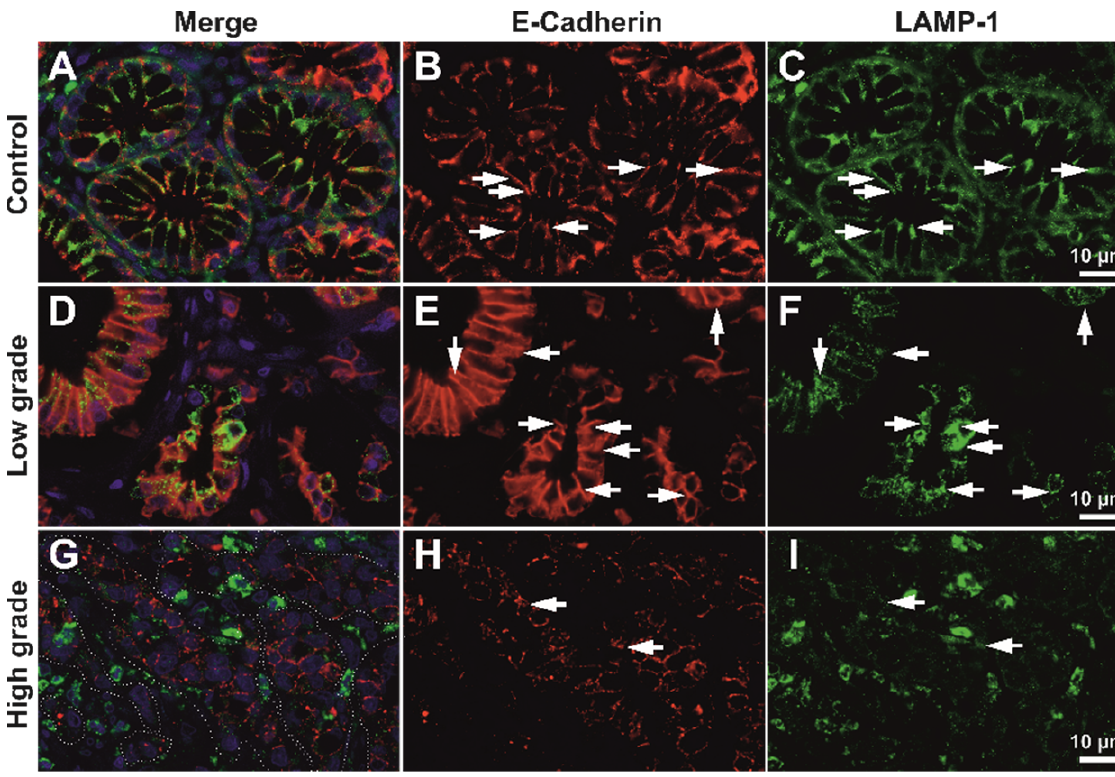
Figure 6. Exemplary deconvolved working images of double immunofluorescence for E-cadherin and LAMP1. Epithelia of control tissue ( A – C ), low-grade ( D – F ) and high-grade ( G – I ) adenocarcinoma were analyzed for expression area and LAMP1/E-cadherin overlap. In image G the dotted line illustrates how epithelia was selected as the region of interest for further analysis; colocalizations are indicated (arrows) at both membrane and sub-membrane and cytoplasmic levels. Scale bar for images A–C, D–F and G–I, 10 μ m.